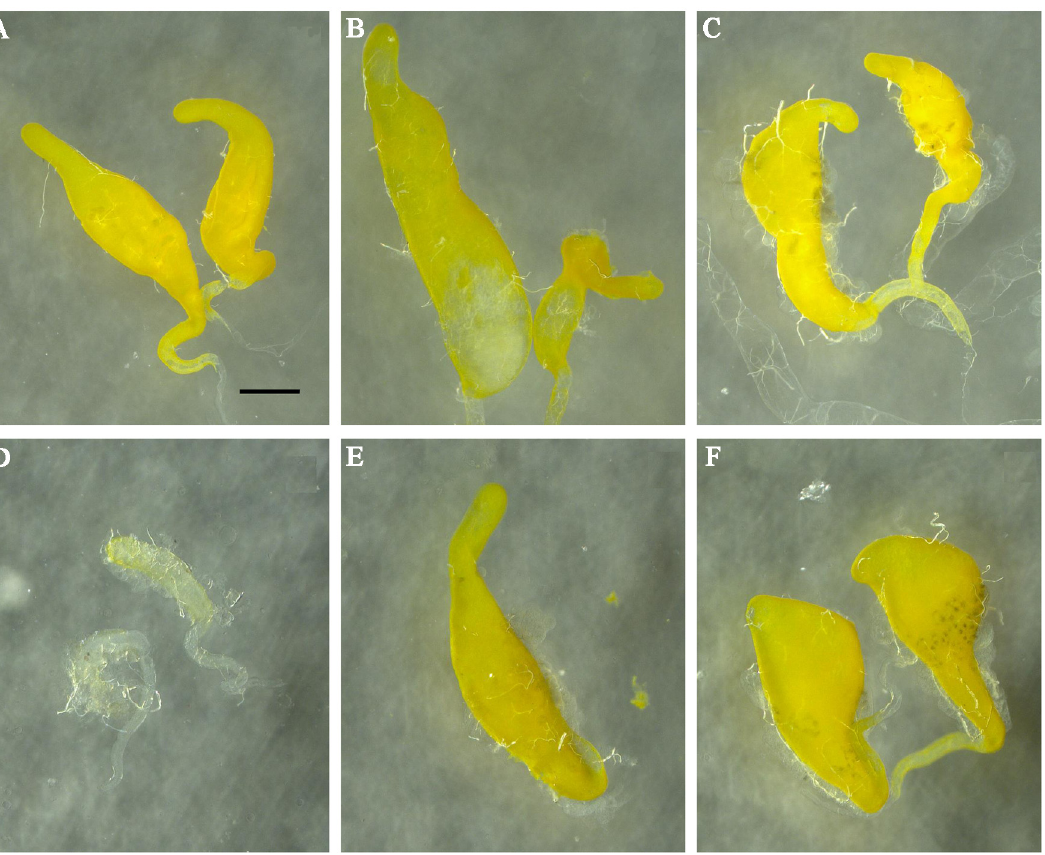
Fig 5. Internal genital structures of RNAi males. Testes of XY males (A) and testes that demonstrated various types of abnormal morphology such as a well-developed testis plus a poorly developed testis (B), hypertrophic testes (C, F), underdeveloped testes (D), single testis (E) from XX-reversed males and intersex individuals. Similar results were obtained for ds Bdtra and ds Bdtra-2 injections. Scale bars are all the same and indicate 0.2mm.